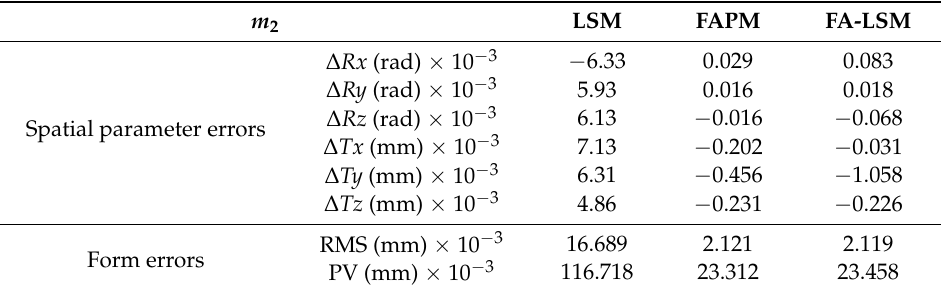
Table 2. Evaluated errors of the six spatial parameters and the form